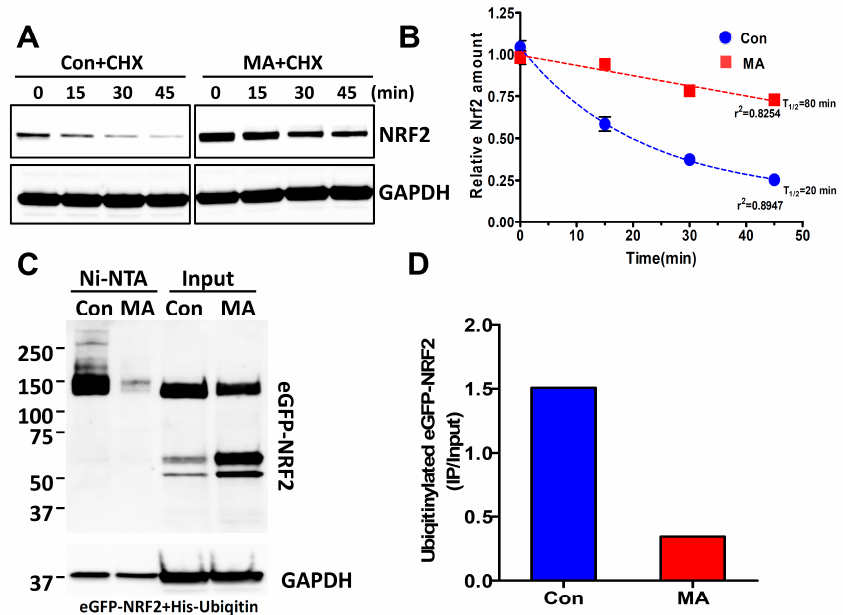
Figure 4. MA increases the NRF2 stability by inhibiting ubiquitin-mediated protein degradation in HeLa cells. ( A ) Cells were treated with MA (5 µ M) for 4 h followed by incubation with cycloheximide (CHX) (5 µ g / mL) for the indicated periods. Western blotting was accomplished with the whole protein lysates. CHX, cycloheximide. ( B ) The stability of NRF2 was analyzed using densitometer from (A). ( C ) Cells were treated with MA (5 µ M) for 4 h after co-transfection of pEGFP-NRF2 and pcDNA3.1-His ubiquitin plasmids. His-ubiquitinated proteins were purified using Ni-NTA agarose beads. Ubiquitinylated eGFP-NRF2 was analyzed by a western blot assay. ( D ) The quantity of ubiquitinylated eGFP-NRF2 was measured using a densitometer from (C).